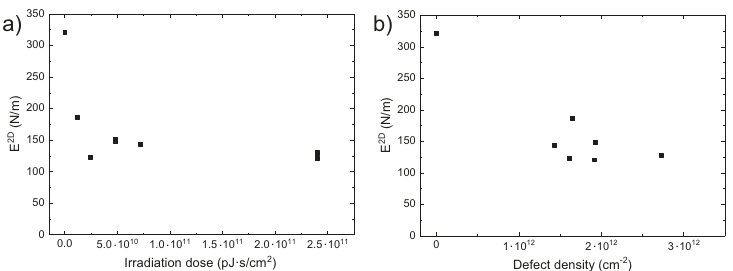
Fig. 2 The effect of optical forging on the 2D elastic modulus of graphene. a E 2D vs. pulsed laser irradiation dose per point. b E 2D vs. defect density.